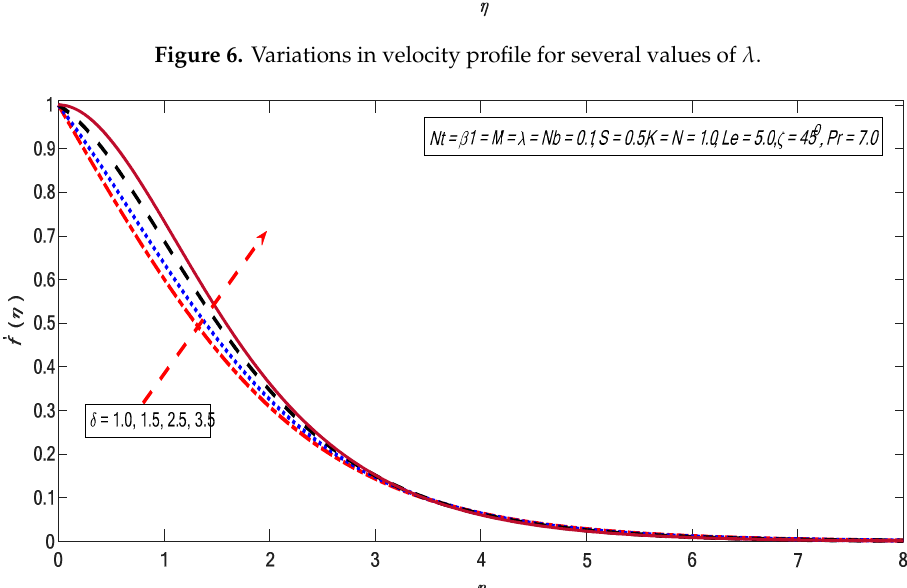
Figure 7. Variations in velocity profile for several values of 𝛿 .